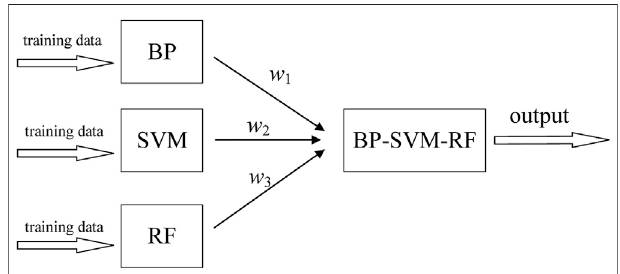
FIGURE 2 | Framework of integrated